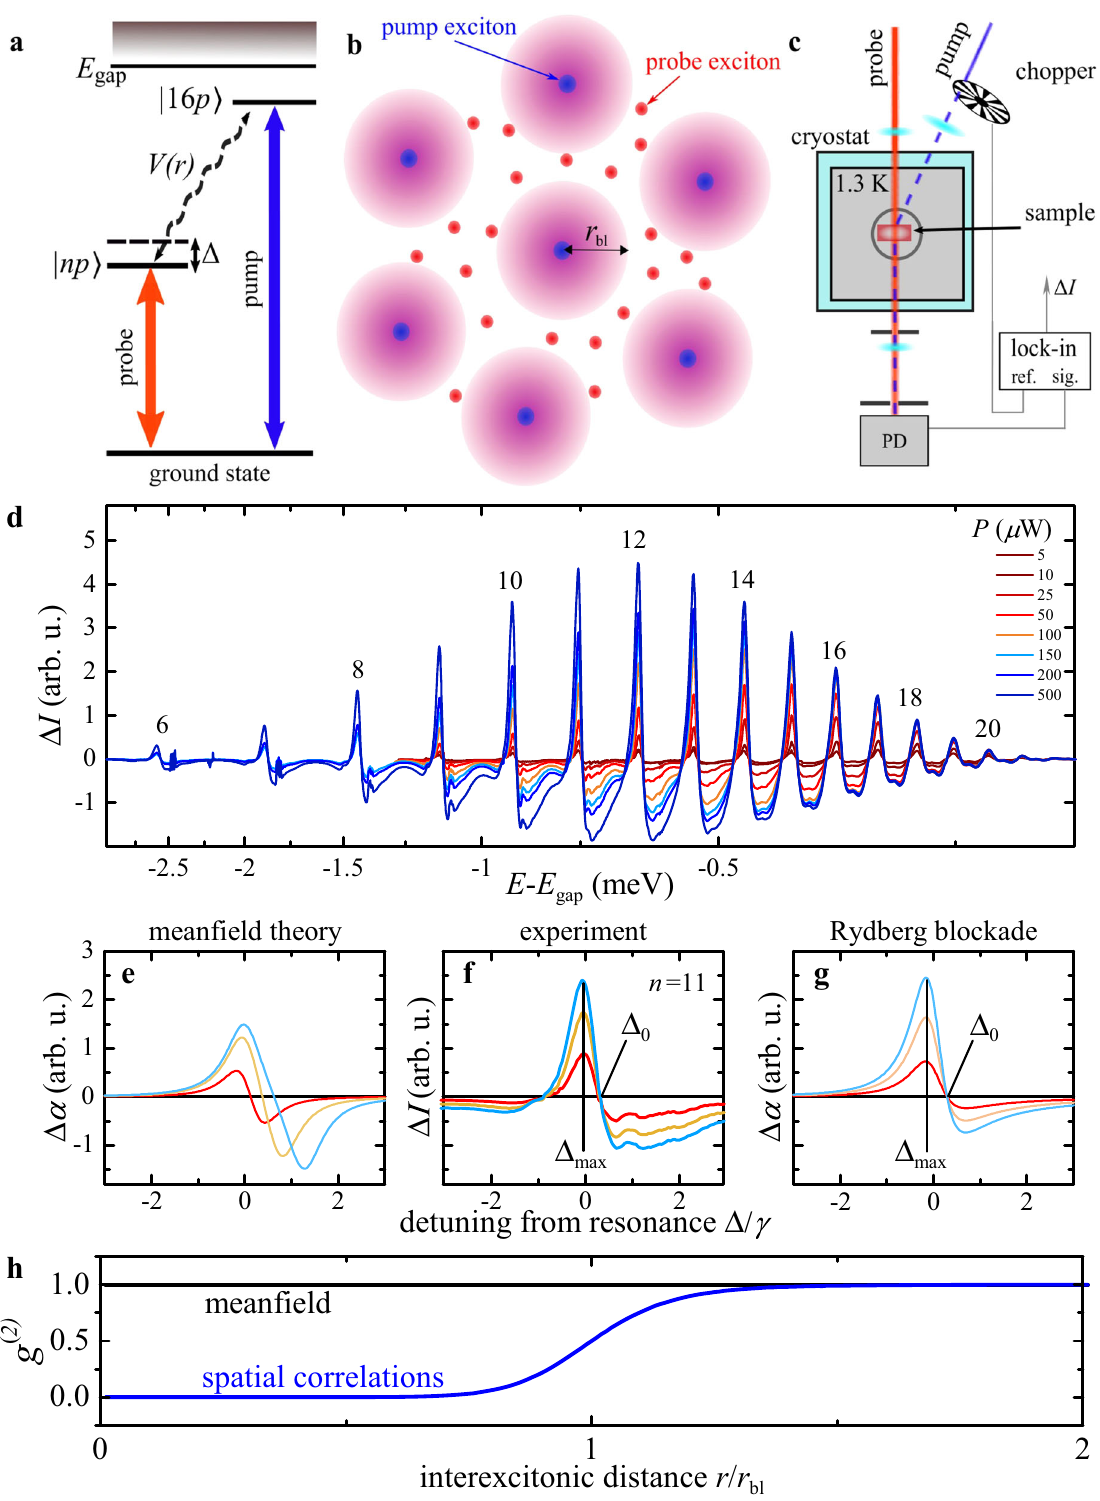
strengths, and stands in stark contrast to our measurements shown in the middle panel of the same fi gure. Such qualitative discrepancies indicate that emerging correla- tions between the interacting excitons play a signi fi cant role during their optical generation. We can explore this further